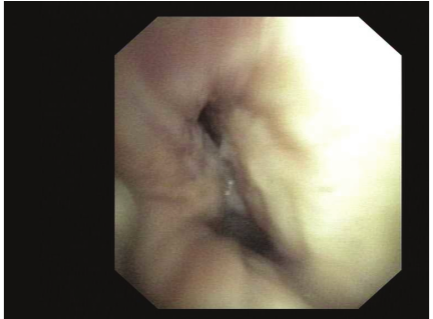
Figure3:Bronchoscopyimageshowingconcentricnarrowingofleft mainstem bronchus with mucosal